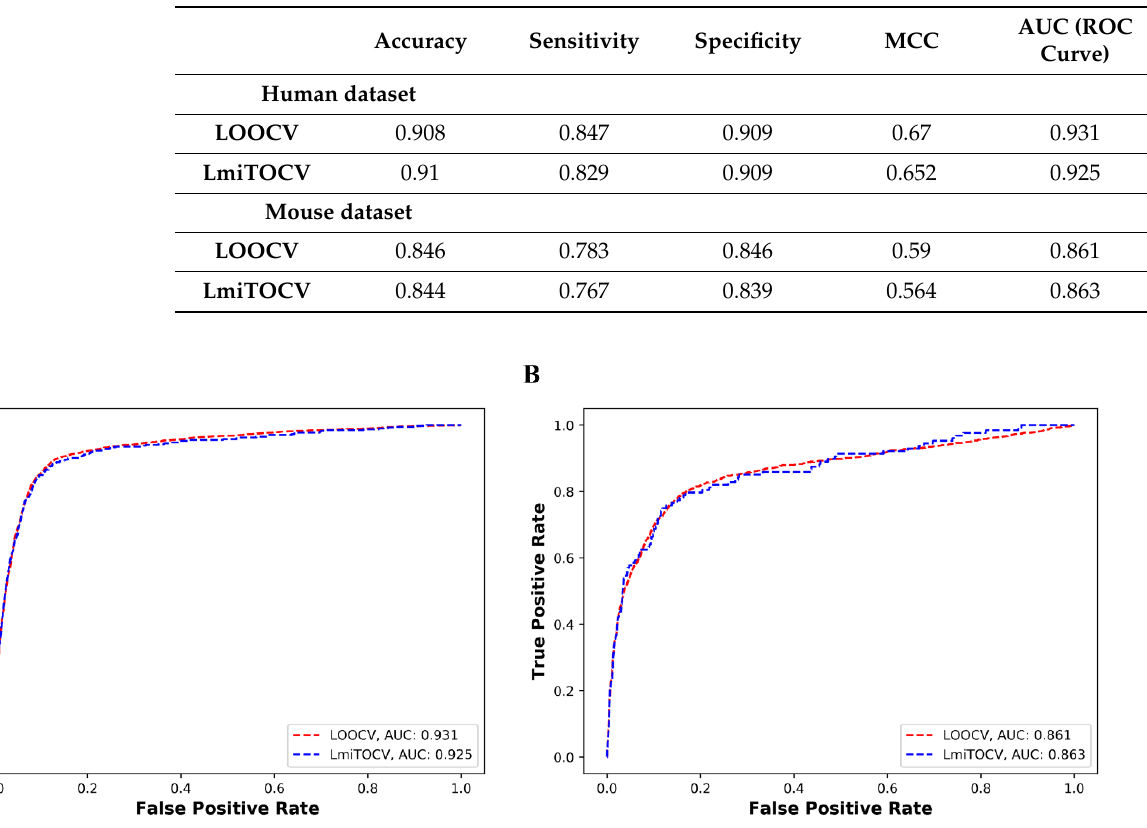
Figure 2. Performance of the mintRULS model using ROC profiling in case of ( A ) human, and ( B ) mouse datasets. miTS: mRNA target site, LOOCV: Leave-One-Out-Cross Validation, LmiTOCV: Leave-miTS-Out-Cross-Validation. Table 1. Performance measurements of mintRULS by different evaluation parameter using human and mouse datasets. LOOCV: Leave-One-Out-Cross Validation, LmiTOCV: Leave-miTS-Out-Cross- Validation, ROC: Receiver Operating Characteristics, AUC: Area Under Curve, MCC: Matthews correlation coefficient.